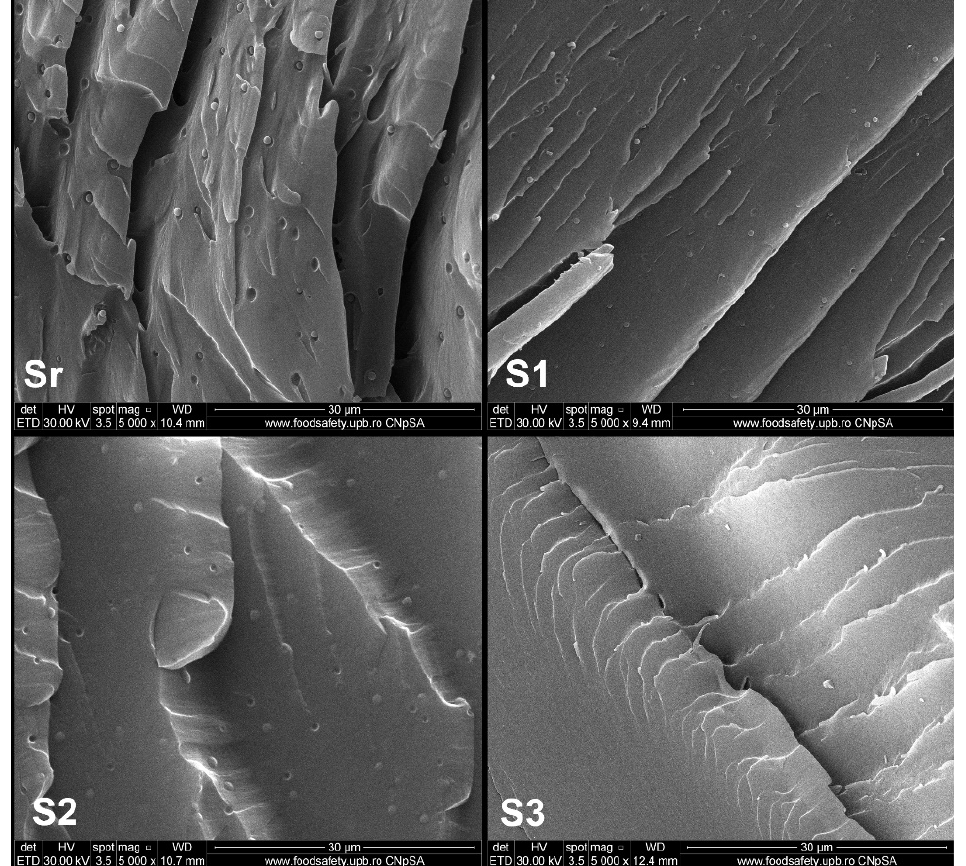
Polymers 2021 , 13 , x FOR PEER REVIEW Figure 5. Cross-section SEM images of ELO-LnK composites (5000× magnification). Sr: ELO poly- Figure 5. Cross-section SEM images of ELO-LnK composites (5000 × magnification). Sr: ELO polymer; mer; S1: ELO+5% wt. LnK; S2: ELO+10% wt. LnK; S3: ELO+15% wt. LnK. S1: ELO+5% wt. LnK; S2: ELO+10% wt. LnK; S3: ELO+15% wt. LnK.